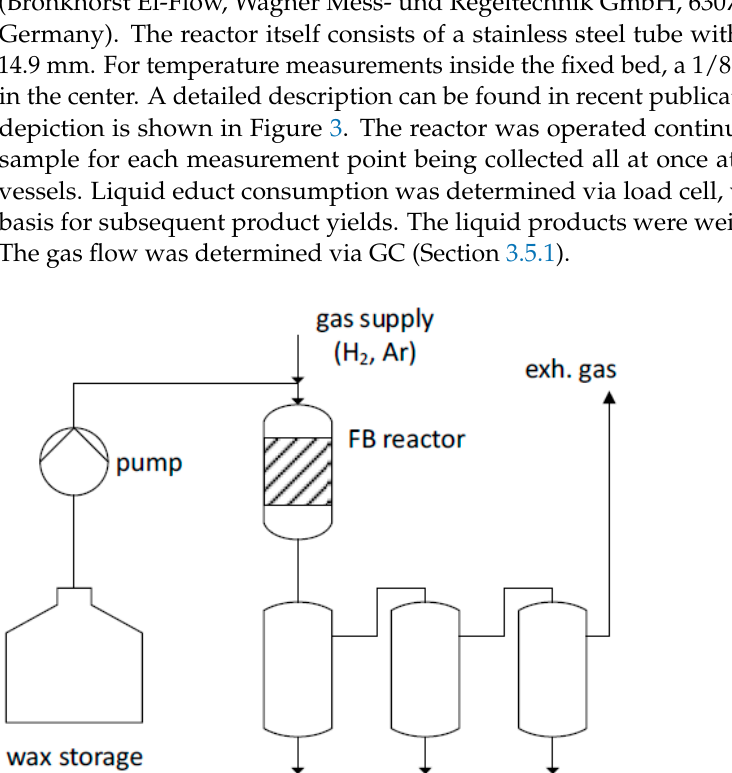
Figure 2. Pyrolysis reactor at the Institute for Technical Chemistry (ITC) at KIT [26].